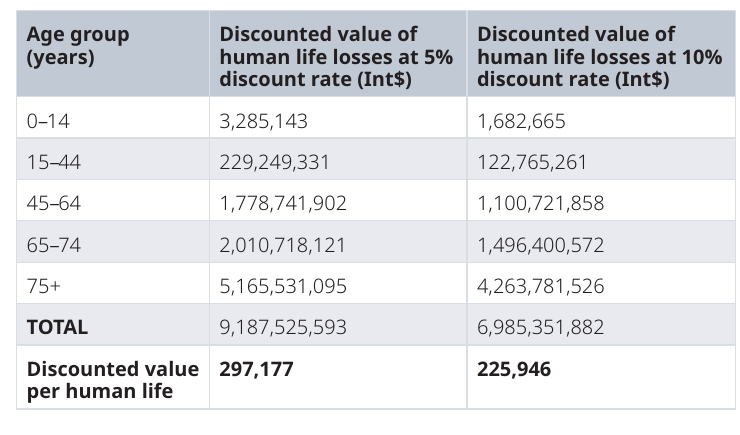
Table 8. Discounted value of human life losses linked to COVID-19 in France, using 5% and 10% discount rates (in 2020 Int$).